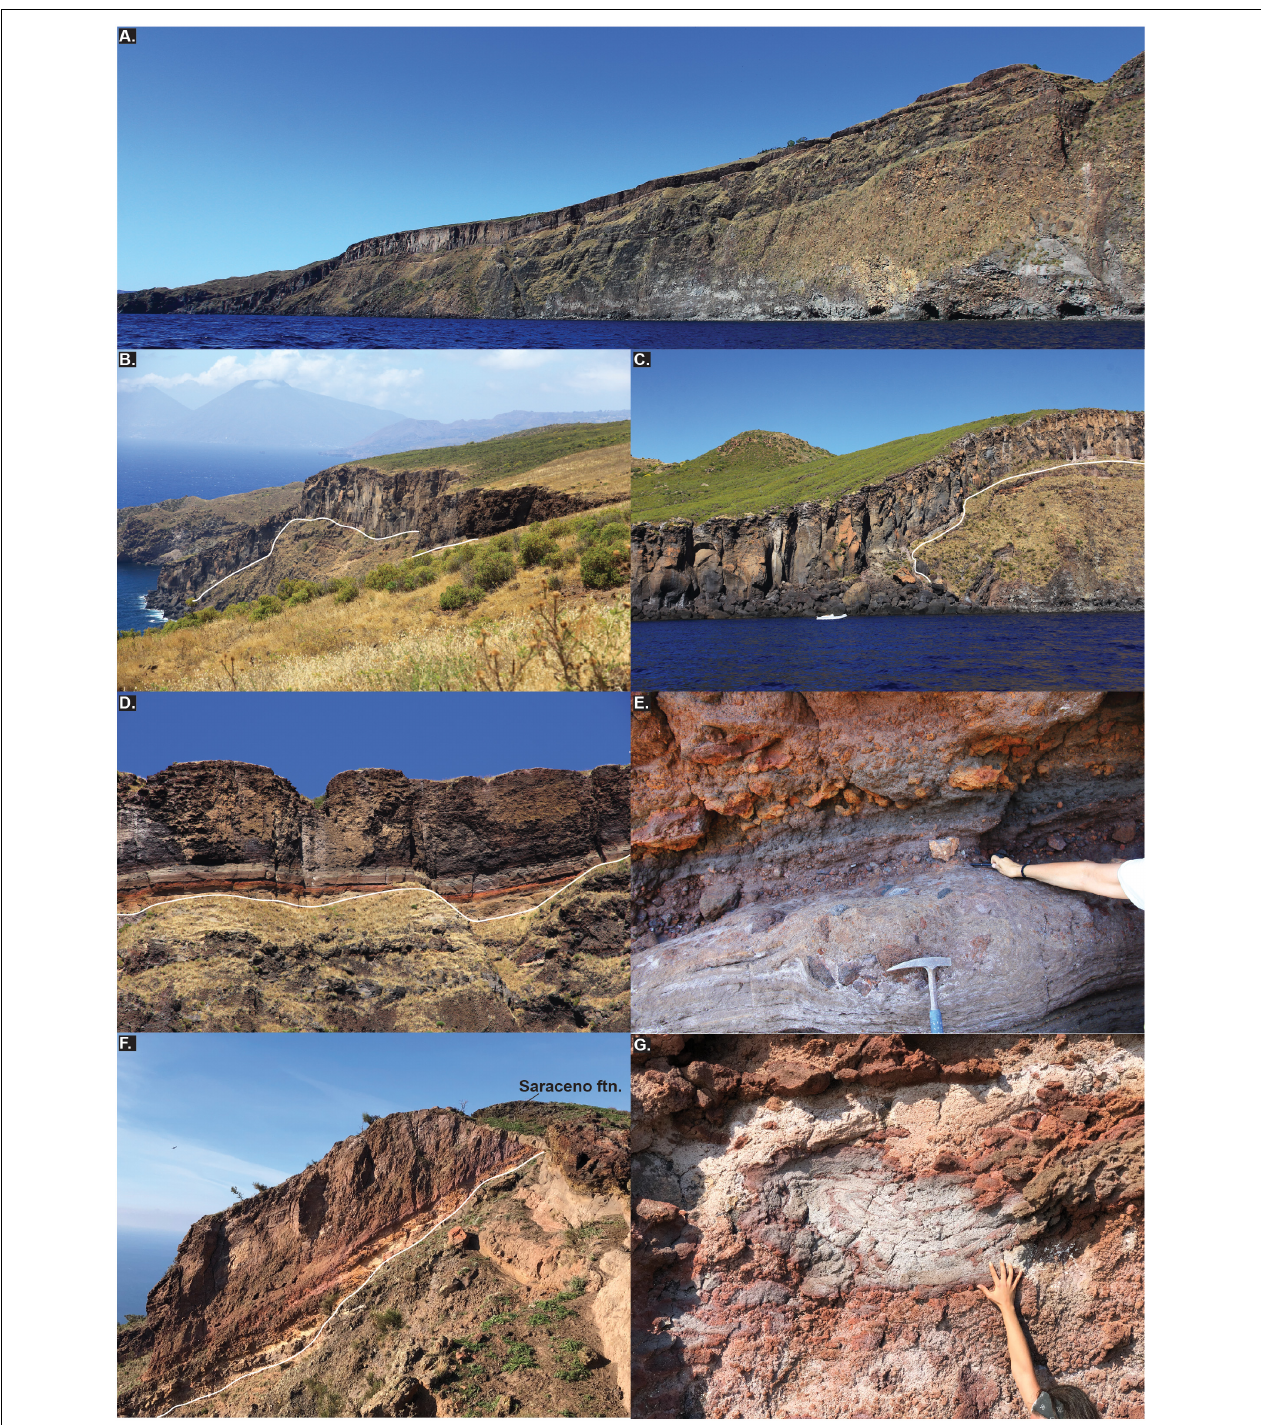
FIGURE 3 | Photos of various areas of Spiaggia Lunga deposits. (A) Panoramic photos of the southern cliffs of Vulcano island; at its top the SL blanket, whose thickness increases from Capo Secco (south) to Punta di Capo Secco (north). (B) Particular of SL deposits. (C) “Lava-like” portion of the SL deposits. (D) Proximal area of SL deposits in a 10 m thick succession: it is possible to see the variation of welding from distal (left) to more proximal (right) portions of the deposit. (E) Particular of the base of the succession of SL deposits at Punta di Capo Secco. A metric block produced a bomb sag on the soft cross-laminated underlying deposits of dilute PDCs. (F) Proximal area of SL Formation, at the top of Monte Saraceno: the two different portions of the outcrops, with different degree of welding, are very evident. At the top, Saraceno ftn. Is overlying with angular unconformity. (G) Lower portion of the deposits of SL in the same location of (F) . It is still possible to recognize an agglutinated spatter